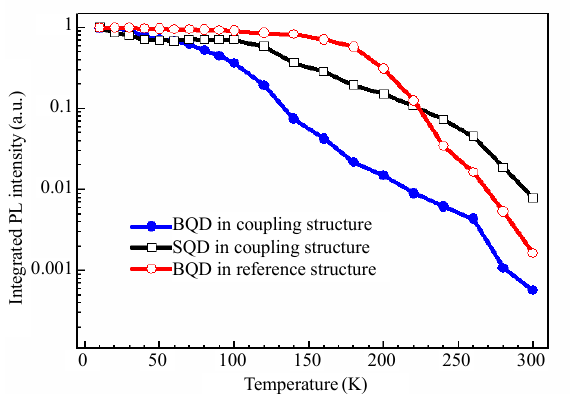
Fig. 4 Integrated PL intensity of two samples as a function of temperature.